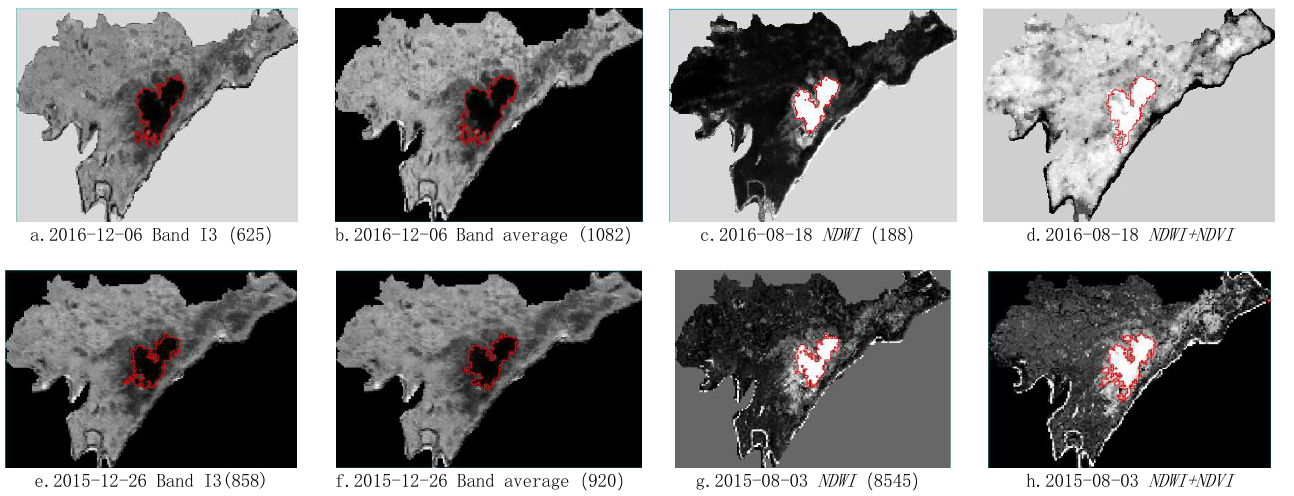
Figure2: The extract water effects comparison on December 26, 2015 and December 6, 2016 VIIRS images in different water extraction methods and different thresholds, where the values in parentheses represent